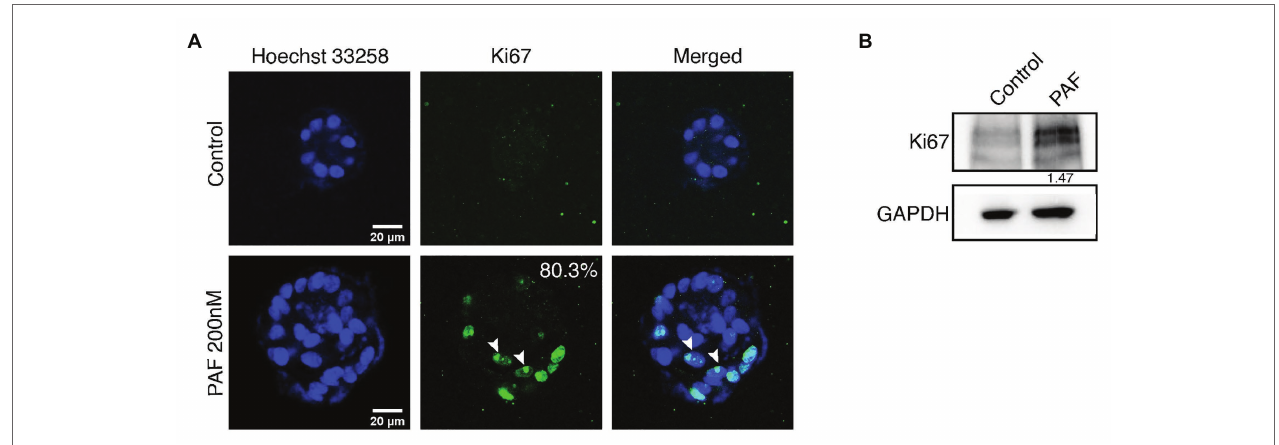
FIGURE 1 | PAF treatment on 3D cultures of MCF10A leads to increased proliferation. MCF10A cells grown as 3D cultures for 20 days treated with and without PAF (200 nM) were immunostained with the proliferation marker, Ki67. (A) Representative image showing hyperproliferation in PAF-treated acini. The data are from N = 5 set of experiments. (B) Protein lysates from 20-day cultures were immunoblotted for Ki67. The values represent the relative expression of Ki67 normalized to